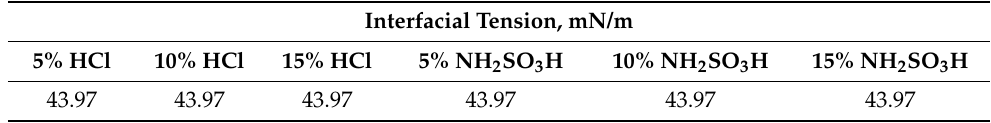
Table 2. Interfacial tension of acid solutions without the addition of inhibitors at the interface with